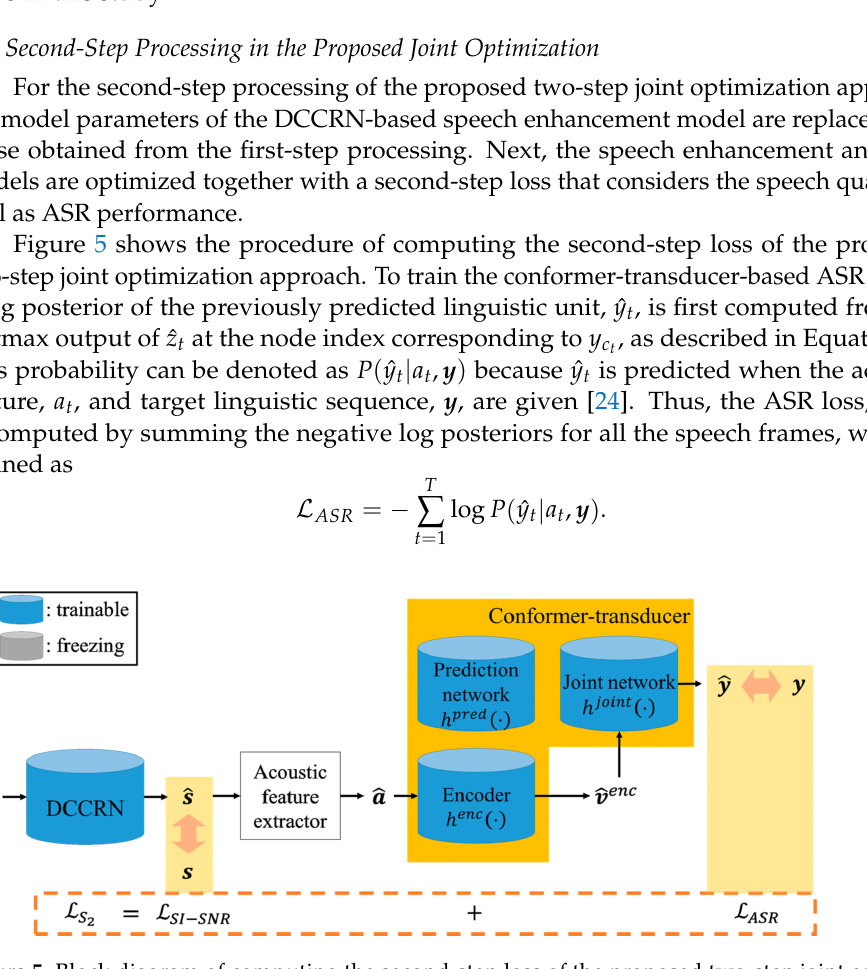
Figure 5. Block diagram of computing the second-step loss of the proposed two-step joint optimiza- tion